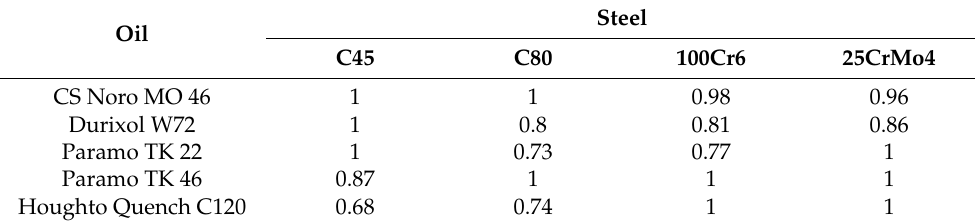
Table 5. Calculated V -values for relevant steels and oils. Oil